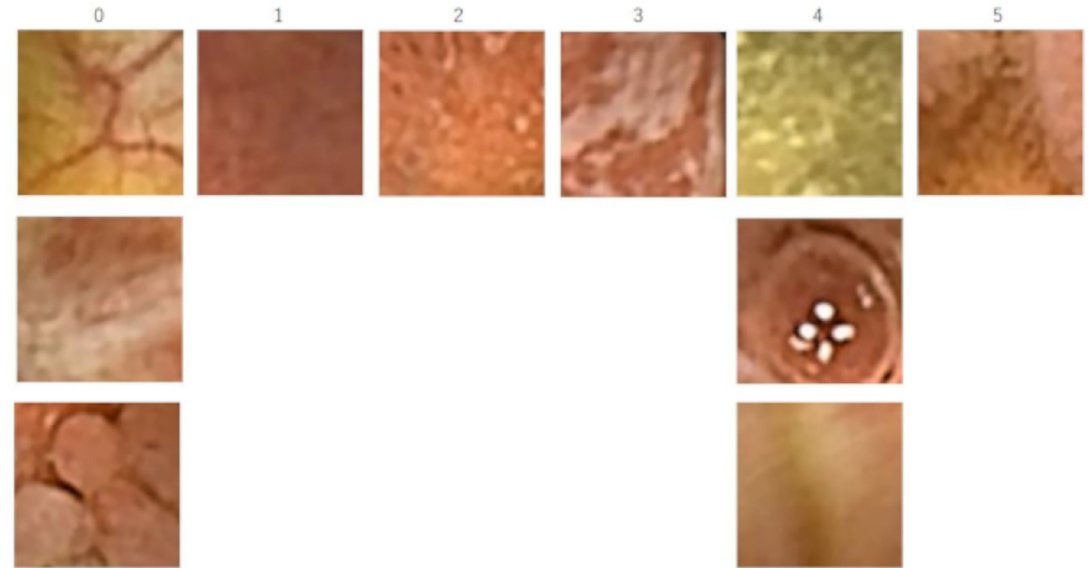
Fig 2. Representative images of the six categories: 0) MES0, normal (upper), white scar (middle) and inflammatory polyps (lower); 1) MES1, decreased vascular pattern; 2) MES2, absent vascular pattern, friability, and erosions; 3) MES3, ulceration; 4) inadequate quality for evaluation, effluent with residue (upper), bubble (middle) and motion blur (lower); and 5) ileal mucosa.